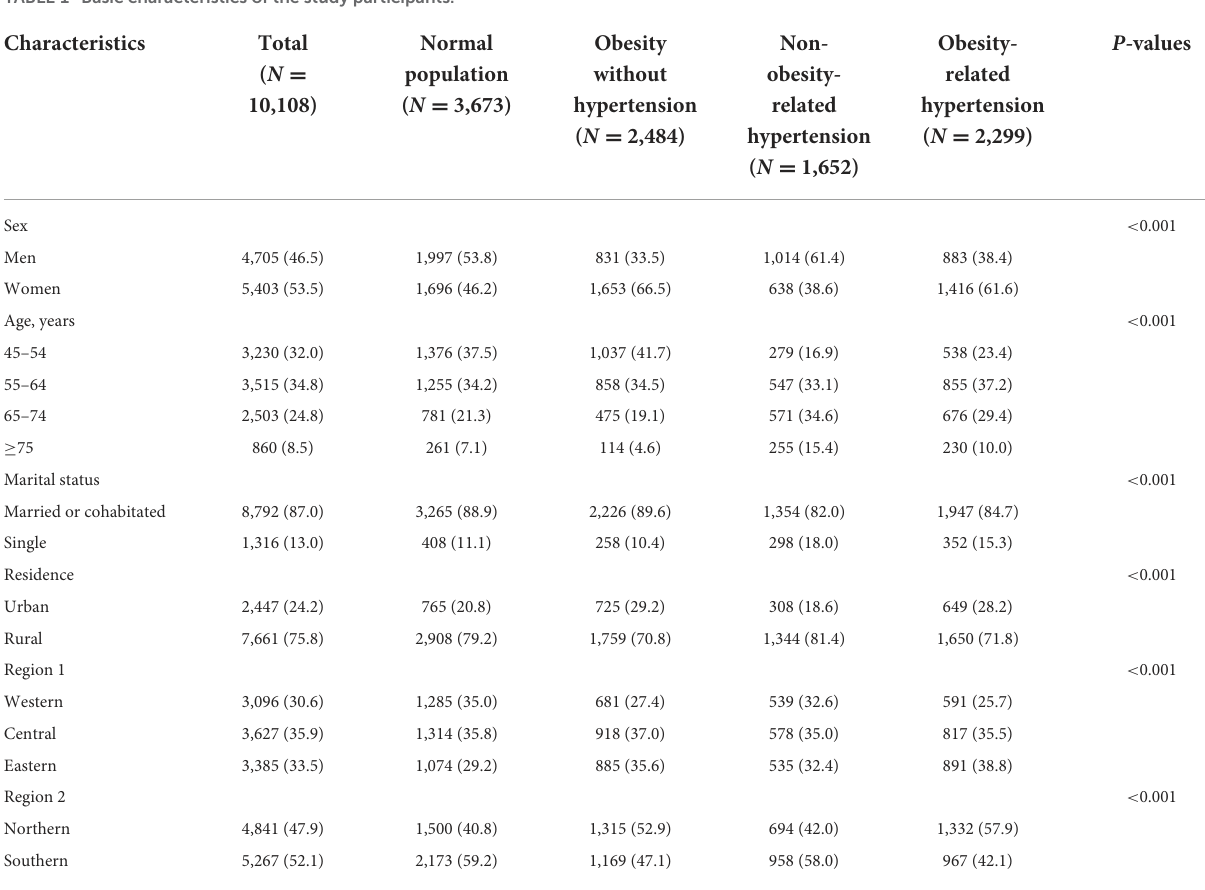
TABLE 1 Basic characteristics of the study participants.